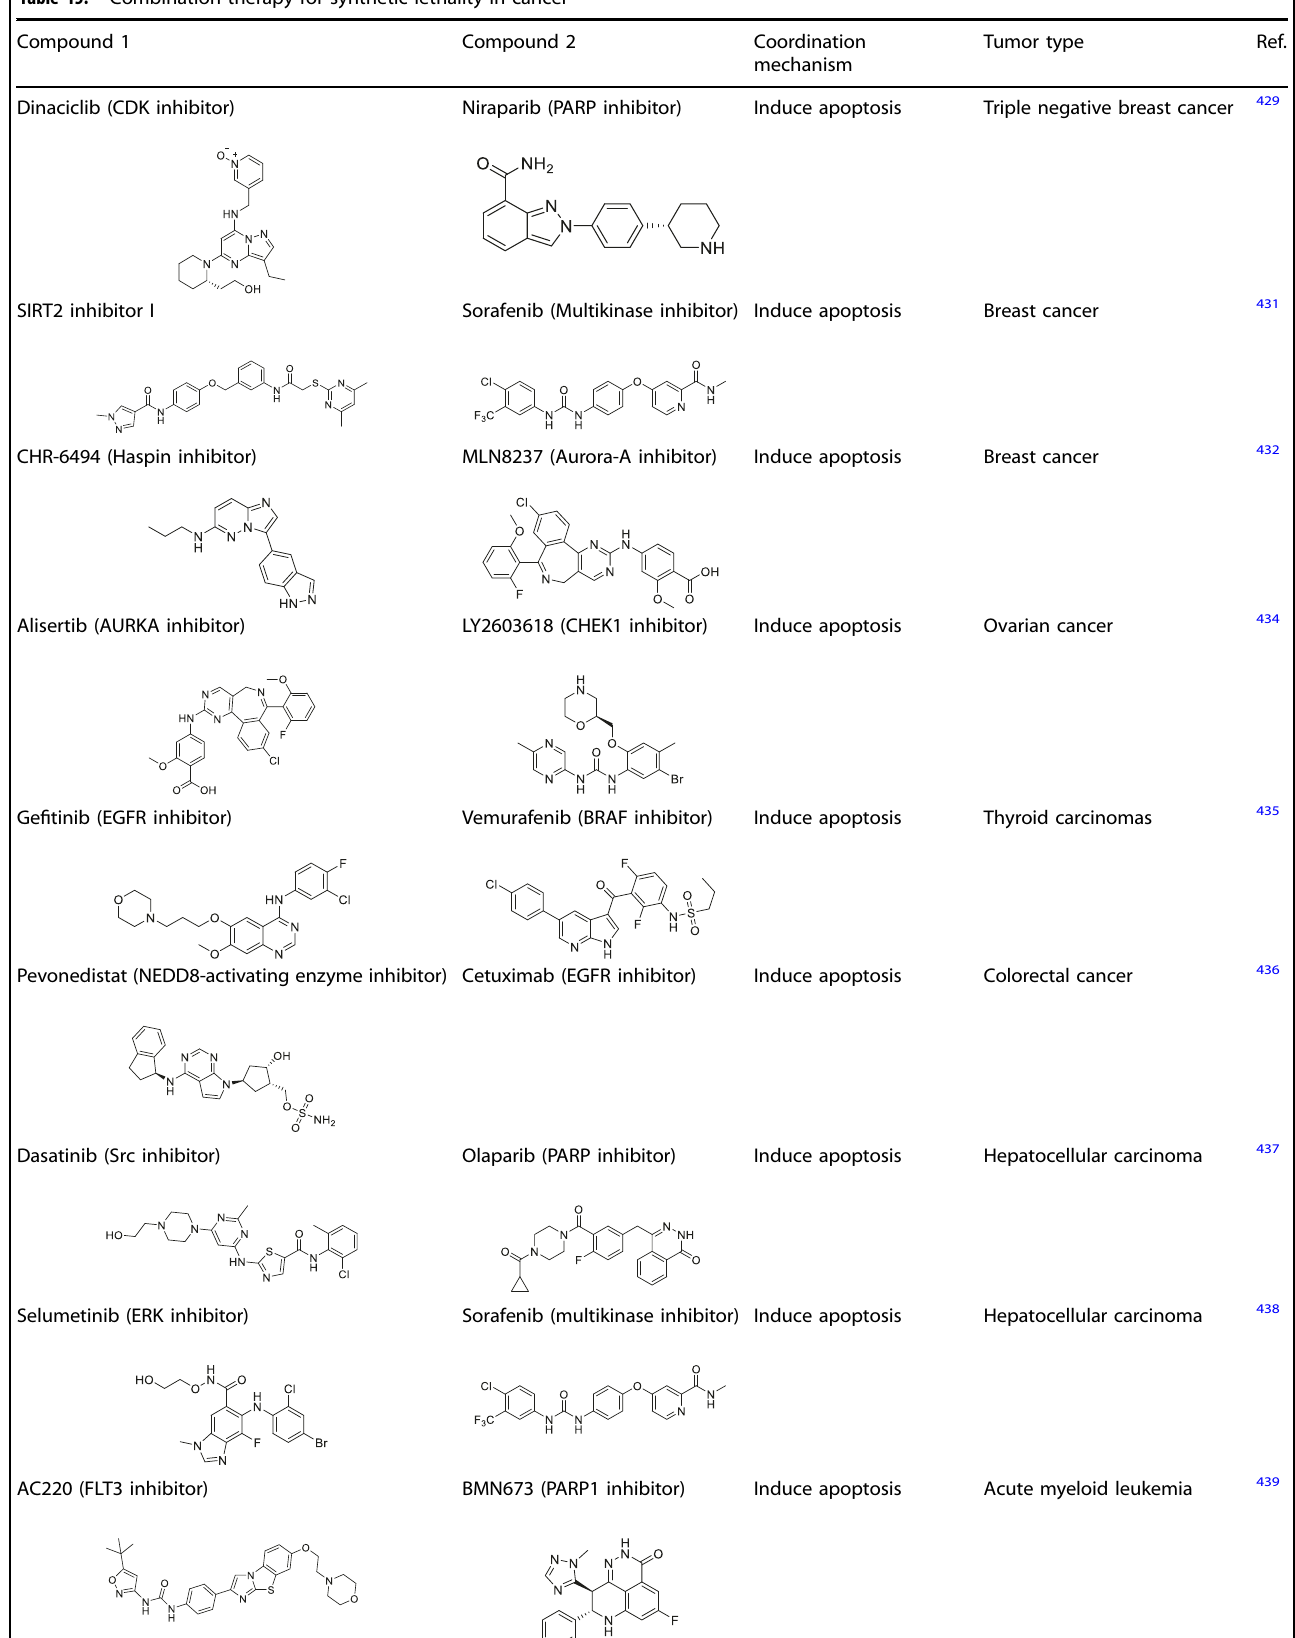
Table 15. Combination therapy for synthetic lethality in